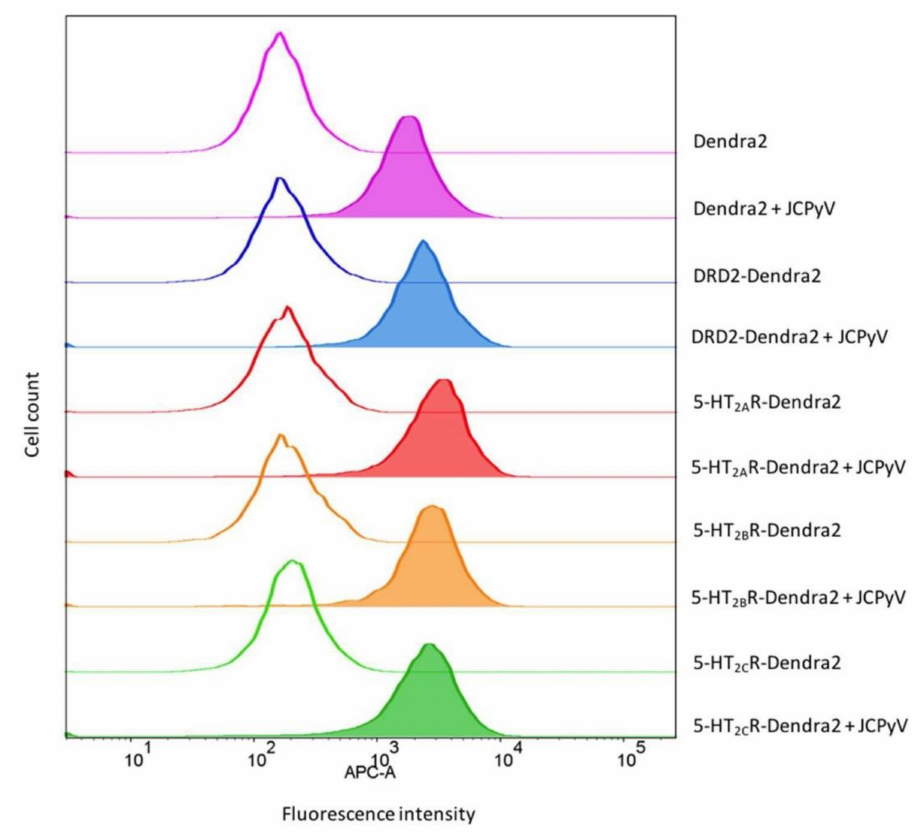
Figure 4. JCPyV attachment is not enhanced in 5-HT 2 R-expressing cells. Indicated stable cell lines were incubated with JCPyV-647 (filled histograms) or mock-treated (open histograms) on ice for 1 h and analyzed by flow cytometry. Histograms represent a comparison of JCPyV-647 attachment to HEK293A cells stably expressing 5-HT 2A R-Dendra2 (red), 5-HT 2B R-Dendra2 (orange), 5-HT 2C R- Dendra2 (green), DRD2-Dendra2 (blue), and Dendra2 (purple) proteins constructs. Histograms represent the mean fluorescence intensities for mock-treated (unfilled), or samples treated with JCPyV-647 (filled). Data are representative of 10,000 events for individual samples representative of 3 independent experiments. Data were analyzed using FlowJo